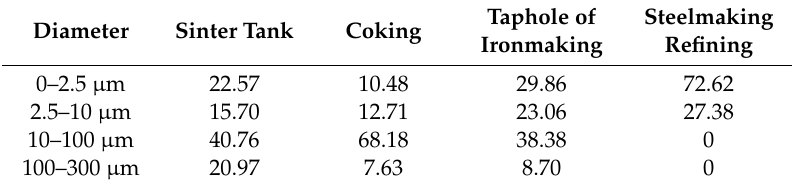
Table 1. The di ff erent diameter distribution in download ash from dust outfit (%). Table 1. The different diameter distribution in download ash from dust outfit (%).